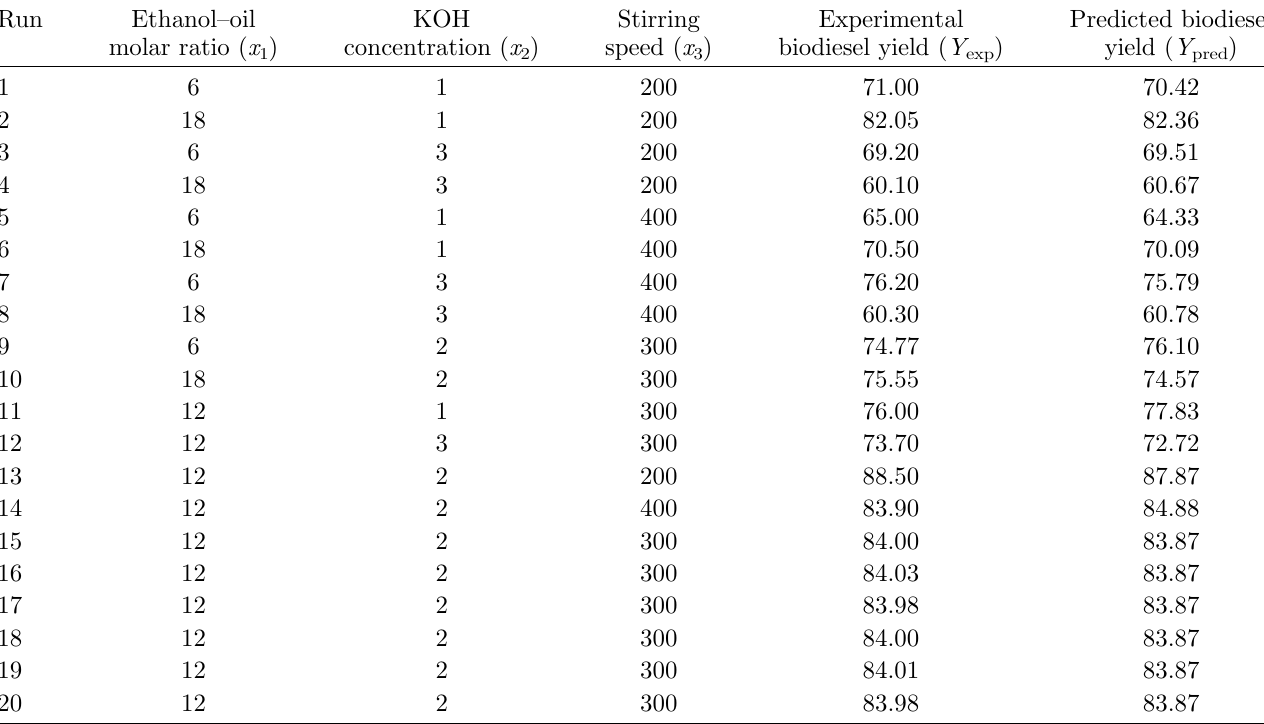
Table 3. Experimental design results for transesteri fi cation of waste cooking.